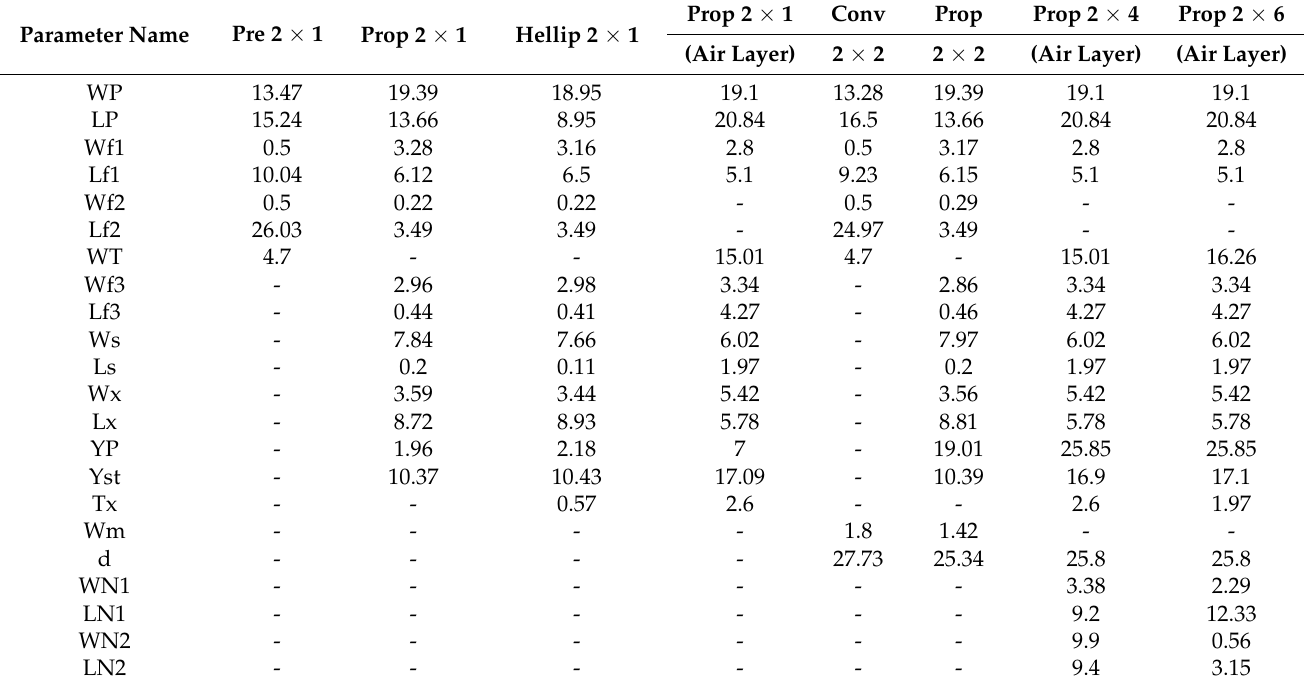
Table 1. Dimensions (Pre = Preliminary, Prop = Proposed with bottom rectangular patch, Hellip = with two half elliptical patches, Conv =